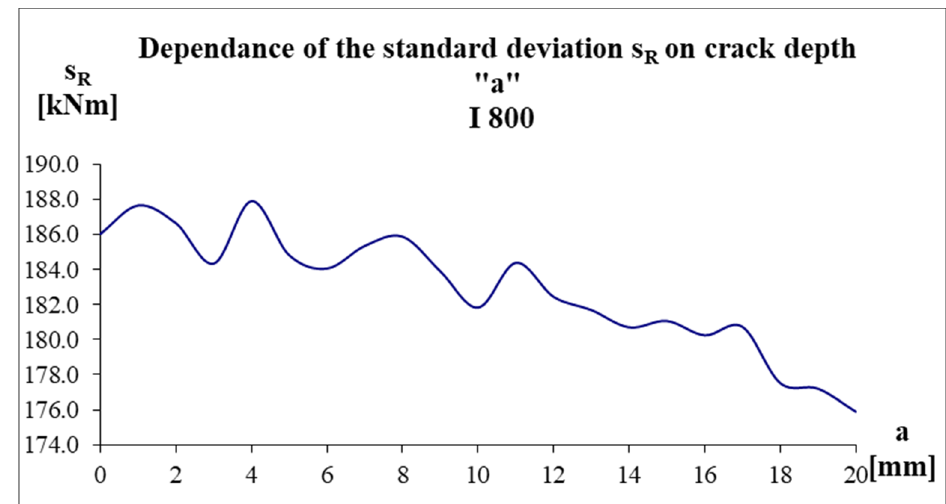
Figure 13. Dependence of resistance standard deviation s R on crack depth “a”.